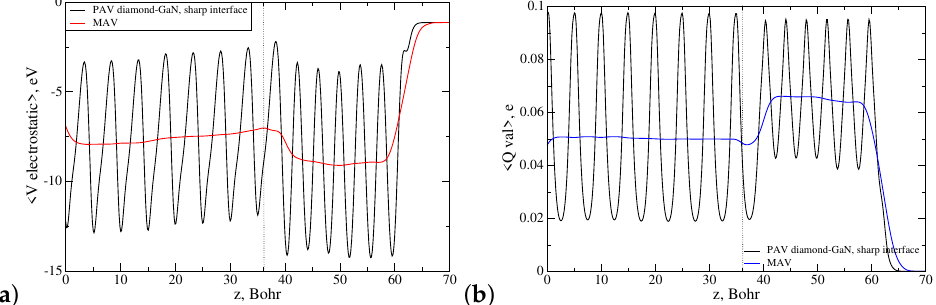
Figure 12. Laterally (PAV) and macroscopically (MAV) averaged profiles of the ( a ) electrostatic potential and ( b ) valence electron charge density of the Ga-C abrupt diamond–GaN interface type. A dotted line points to the average z-th position of the topmost Ga